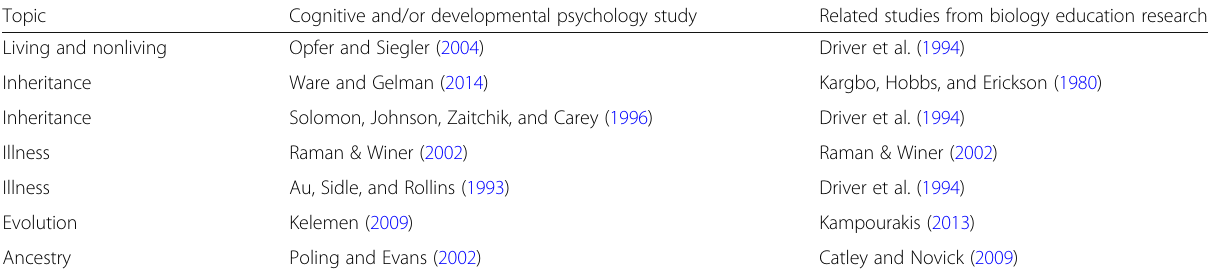
Table 4 Examples of cognitive psychology studies exploring biological reasoning in young children and related learning challenges in young